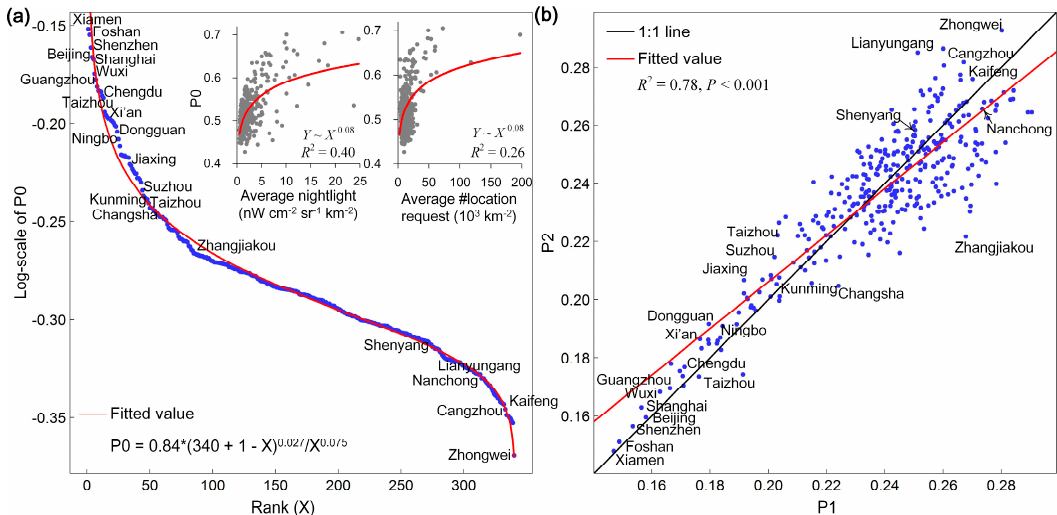
Figure 7. ( a ) Rank-ordered distribution of P0 (here, a base-10 log scale is used) across 340 Chinese cities. Two insets show the relationships between P0 and the average nighttime light radiance ( left ) and the density of location requests ( right ) according to a power law; ( b ) Quantitative comparison between P1 and P2 (see main text and Figure 6a for definitions) among 340 cities in China. Apart from the measurements of P0, a cross-regional comparison of the proportion of ML+HM+HL (P1) with the proportion of LM+MH+LH (P2) could further portray the variations in the